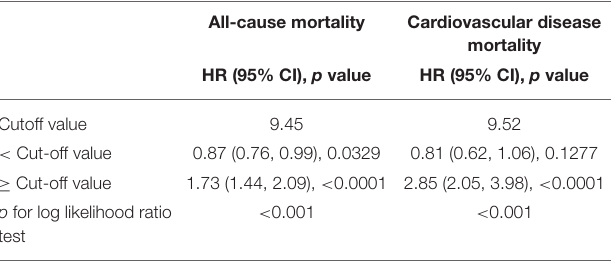
TABLE 3 | The results of two-piecewise linear regression model between triglyceride-glucose index and cause-specific mortality. All-cause mortality Cardiovascular disease